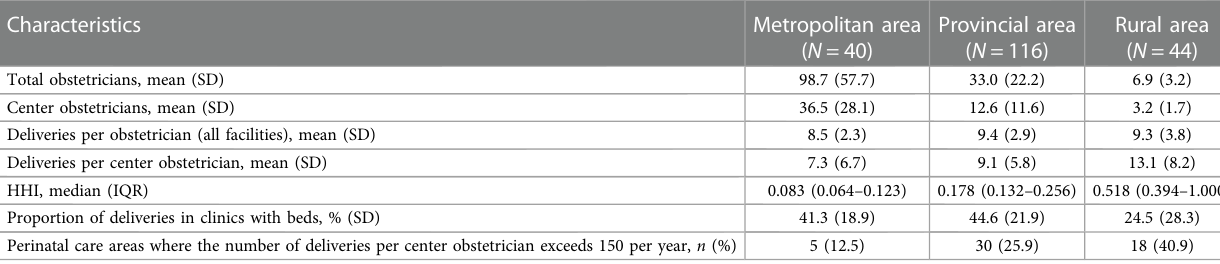
TABLE 2 Characteristics of the average of each perinatal care area in the designated perinatal centers (excluding medical regions without a perinatal center).